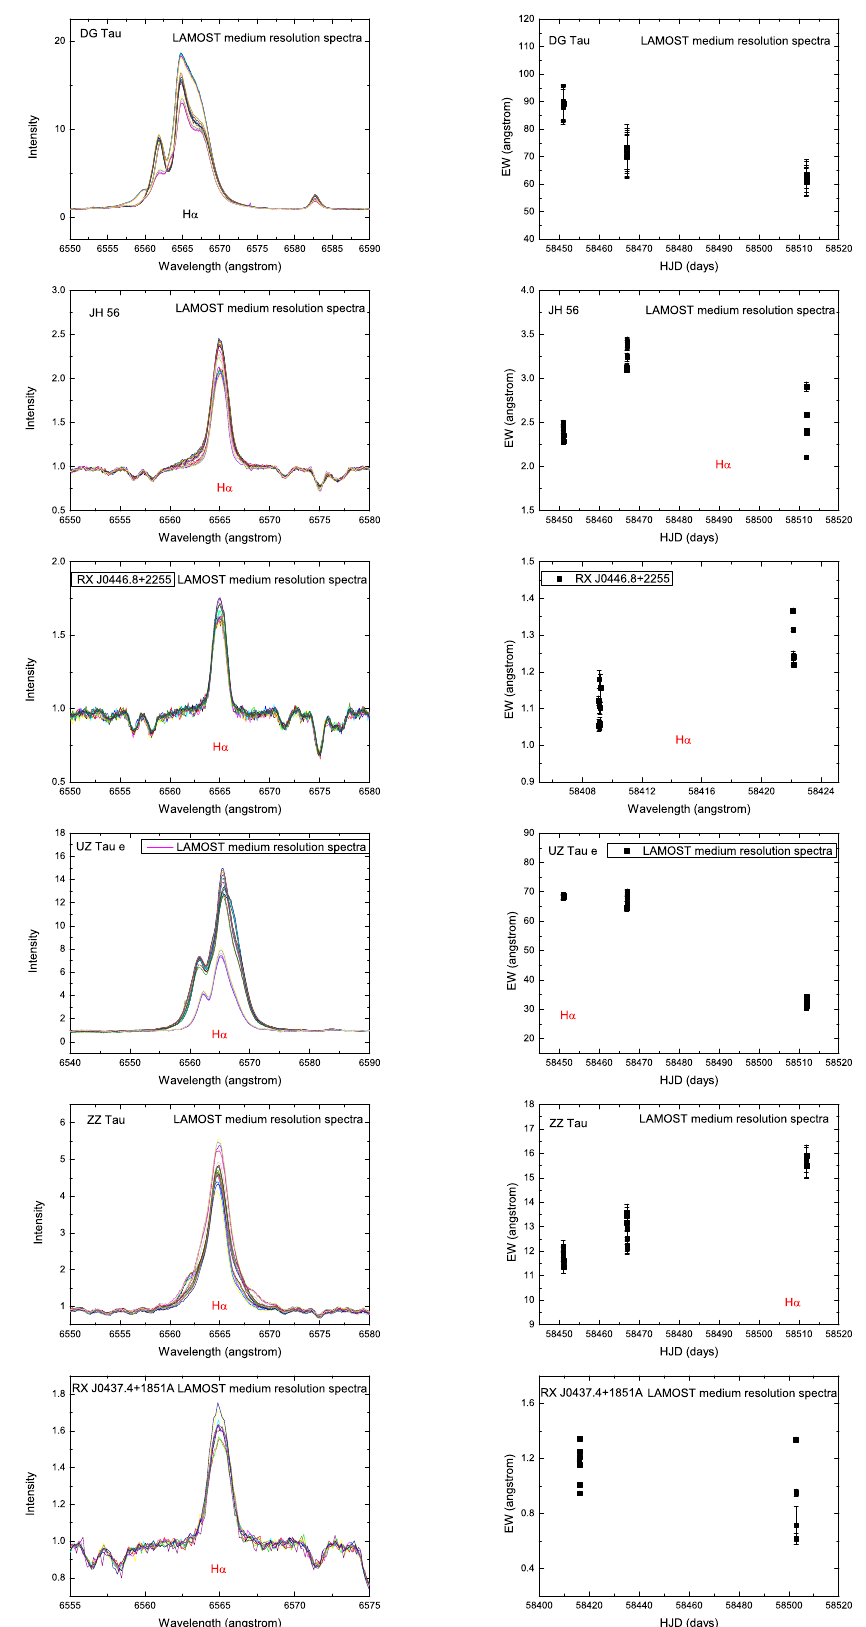
Figure 7. Medium resolution LAMOST spectra of radio stars with repeated observations over a long time scale of several months ( left ). There are obvious long-term variations in the EWs of H α , as shown in the ( right )